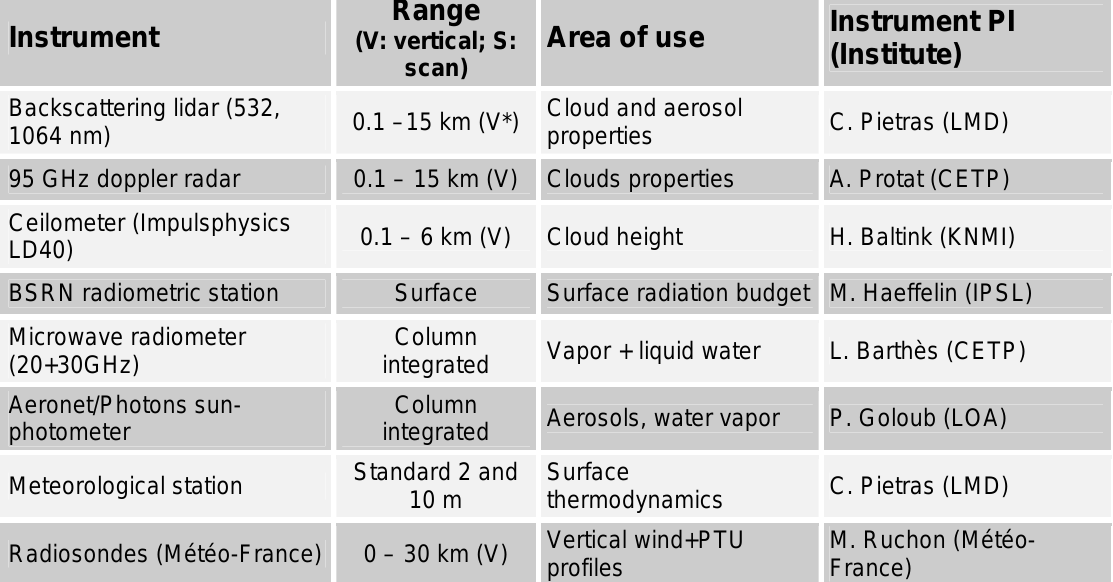
Fig. 2. Photographs the main components of the SIRTA observatory: overall view of the Ecole Polytechnique campus (center panel), measurement platforms (top panel), (A) LNA lidar, (B) RASTA radar, (C) ceilometer, (D) surface radiative flux station, (E) Drakkar MWR, and (F) Sun-photometer. Table 2. List of instruments operated routinely or continuously at SIRTA. Table 2: List of instruments operated routinely or continuously at SIRTA Instrument